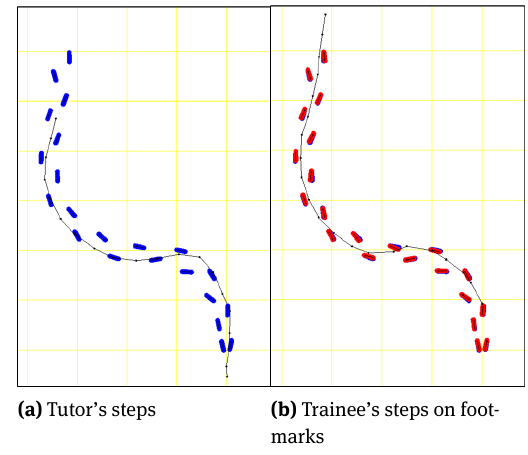
Fig. 24. Result of S-type